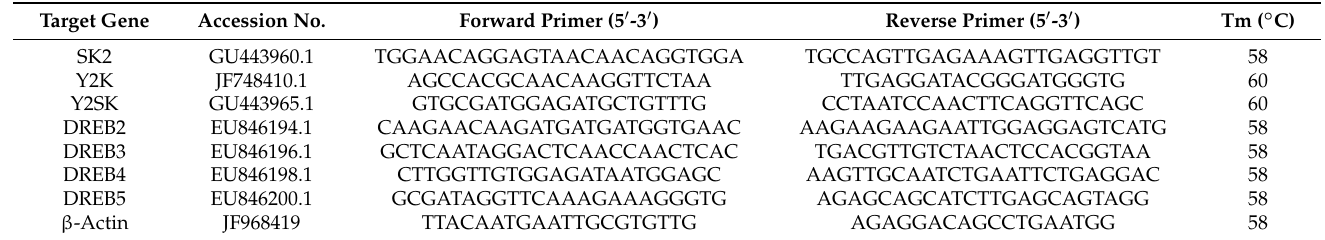
Table 1. Primer sequences and GeneBank accession numbers of genes.